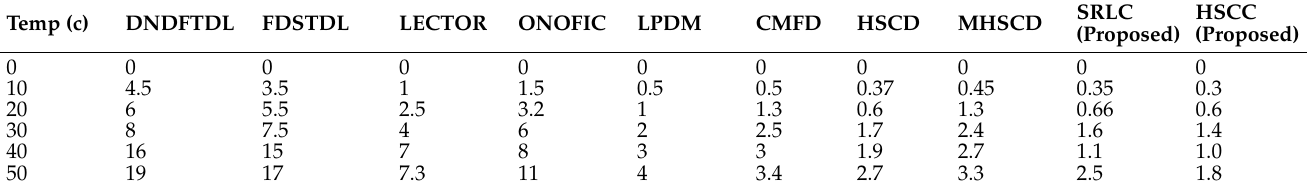
Figure 20. Simulation of delay with the variation of temperatures at different V dd of FinFET-based SRLC circuit at 7 nm.